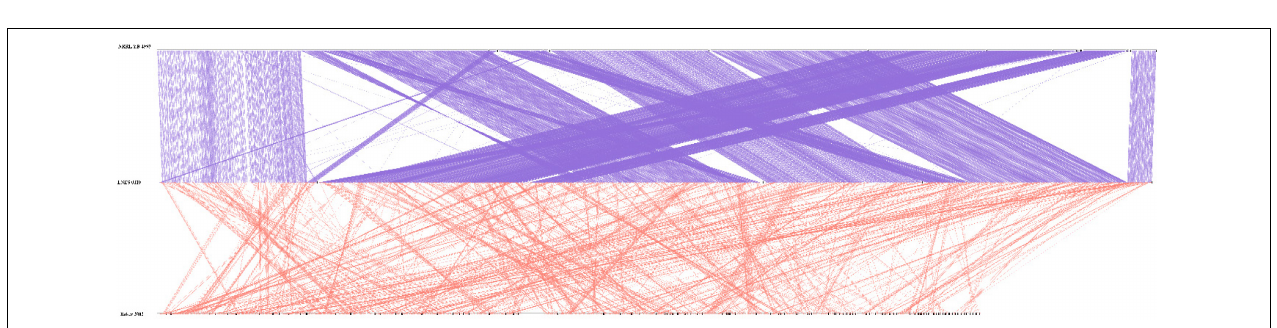
FIGURE 4 | Interspecific phylogenic tree of three M. bicuspidata strains and M. aff. pulcherrima .